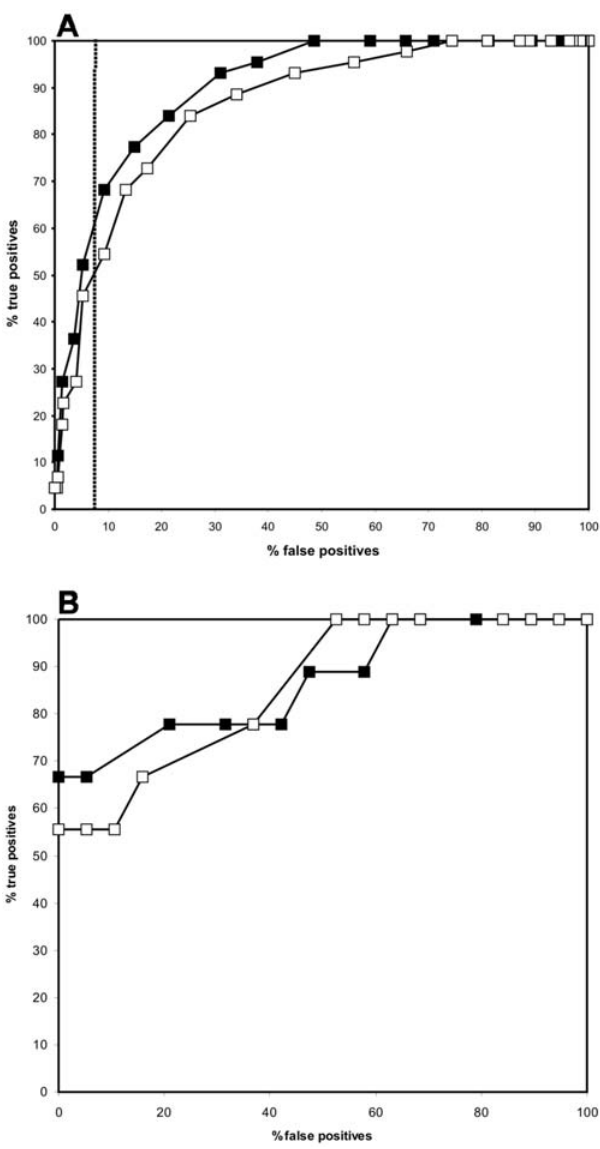
Figure 7. ROC performance comparison with a previously published algorithm. A: Comparison of our DnaK predictor (closed square) with the previously published predicting algorithm from Ru¨diger et al [3] (open square) for the extended benchmark peptide set. The data point above 90% specificity (90.7%) with the best MCC in both predictors is shown as a dashed line. B: ROC curves comparison between our predictor (closed square) and the algorithm of Ru¨diger et al (open square) for the validation set of peptides.